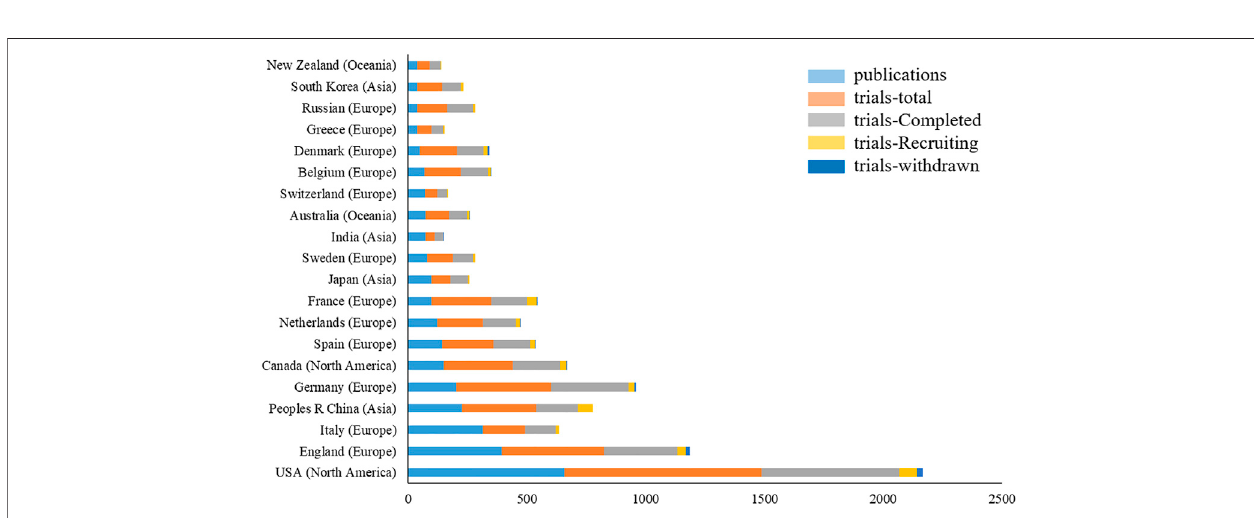
FIGURE 2 | Top 20 countries that published COPD drugs-related studies and the relevant clinical trials from 1980 to 2021.